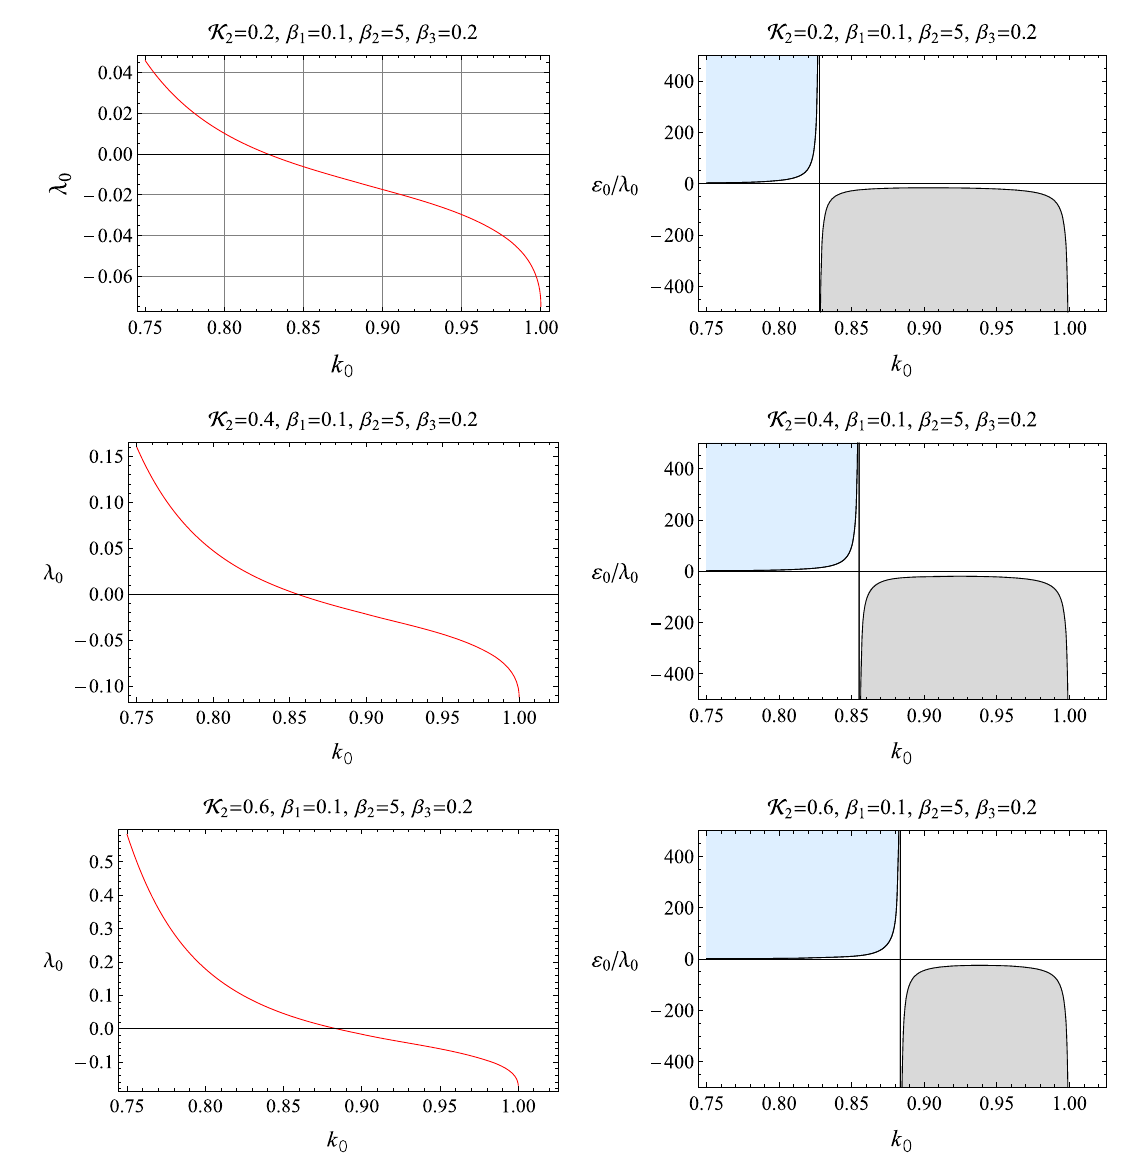
Fig. 11 Stable regions for the choice of first shape function (case(ii)) for different values of K 2 . Here, the shaded regions show the stable regions of developed